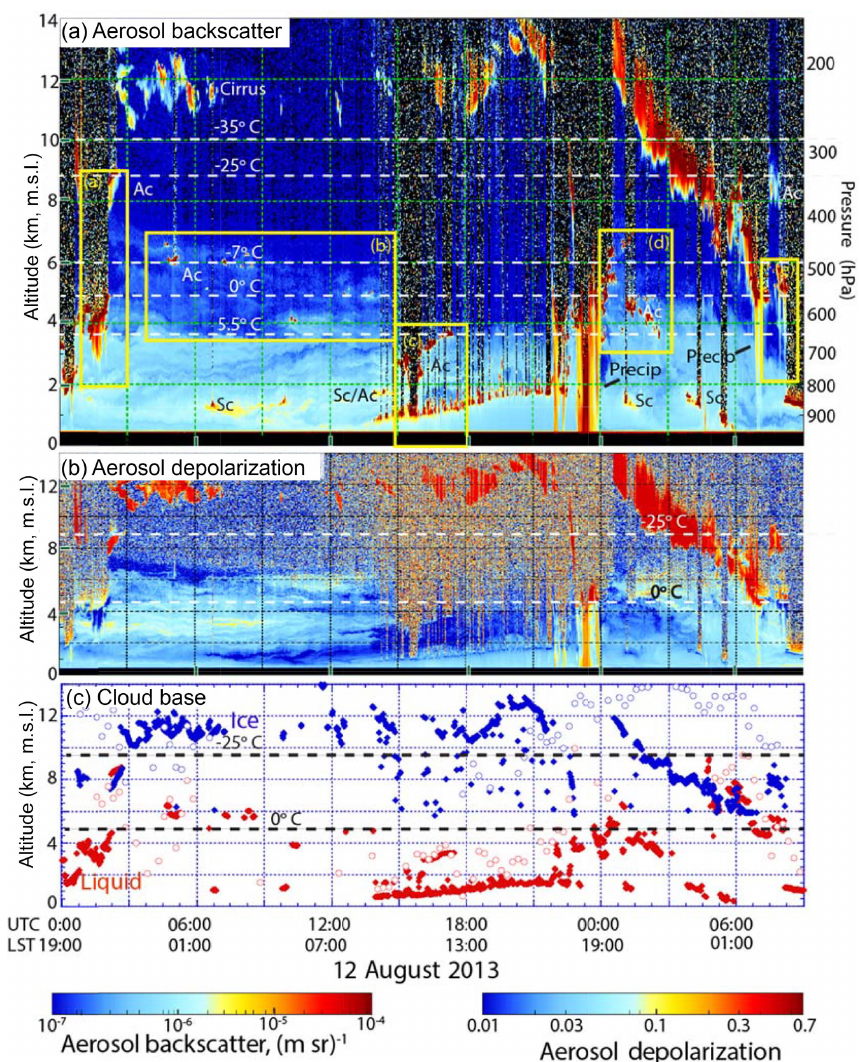
Figure 4. Example lidar data for 12 August 2013. UW HSRL aerosol (a) backscatter and (b) depolarization from the surface to 14kma.g.l. Listed are cloud types; phenomenon; and, from a 13:30 radiosonde release, key temperature isopleths. Also shown in (c) are liquid and ice cloud bases (solid) from the ground-based HSRL and liquid and cloud tops from GOES-13 (open). To convert from a.g.l. to m.s.l., subtract